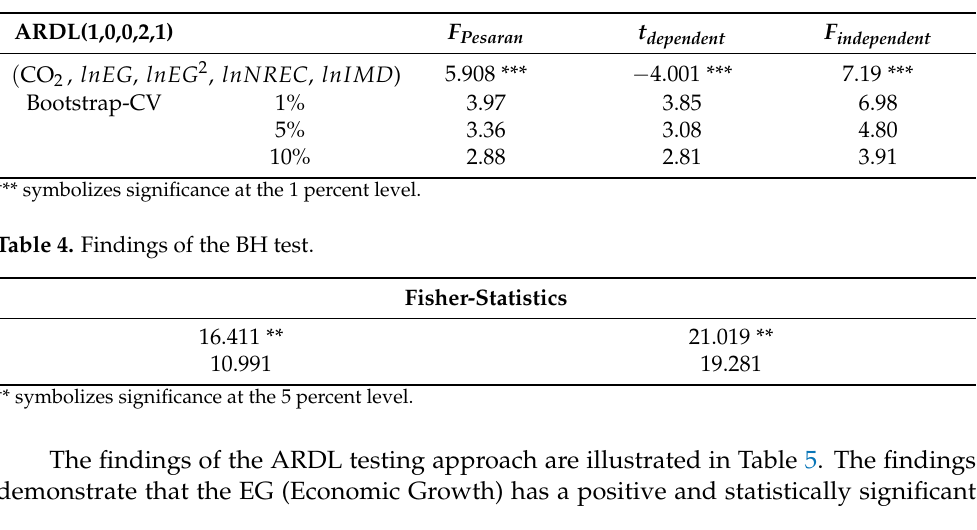
Table 3. Findings of the Bootstrap-ARDL test.